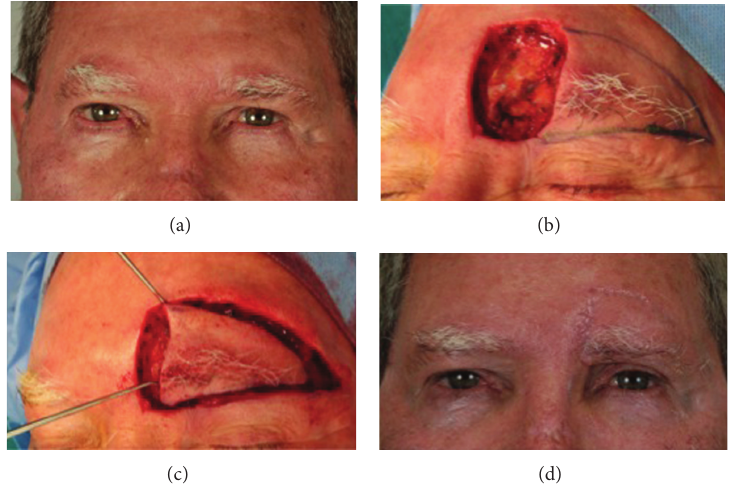
Figure 3: a 78-year-old male underwent squamous cell carcinoma tumor removal from the medial region of the left eyebrow. Histology showed tumor infiltrations in the margins so wide excision was planned (a). A 3cm wide defect was produced, and a freestyle-like V-Y advancement flap was used to close the defect (b, c). Cosmetic appearance was considered satisfactory at follow up 3-year postoperatively